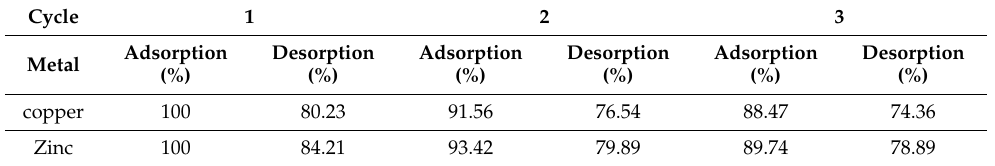
Table 5. Data of three cycles of metal